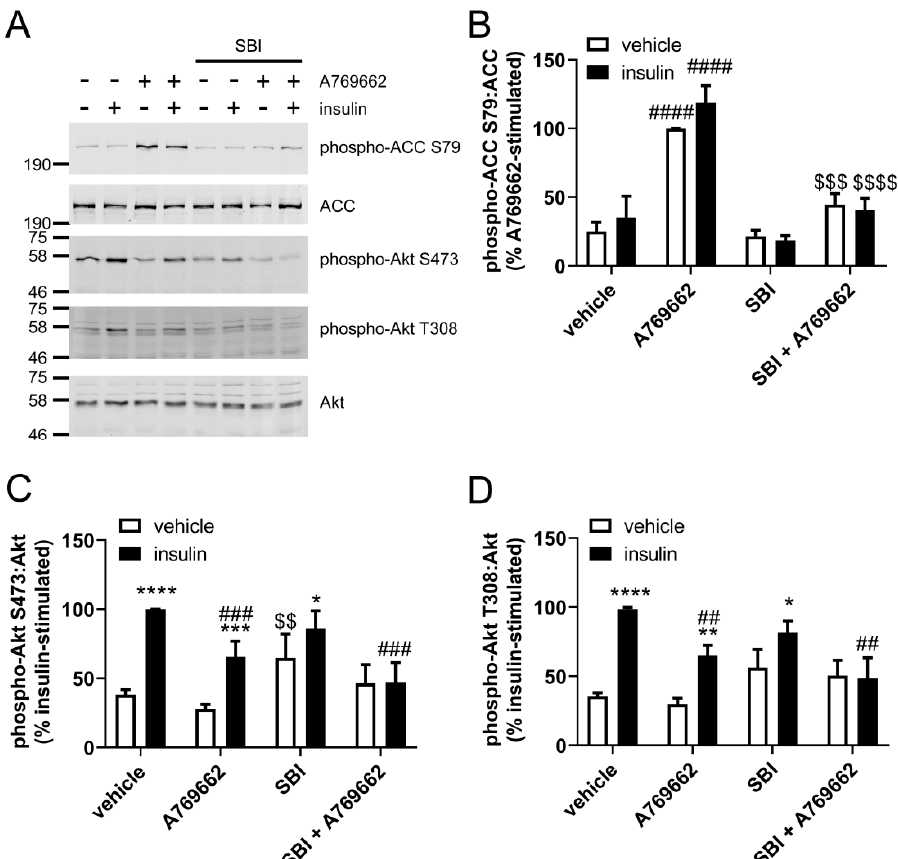
Figure 4. SBI-0206965 inhibits A769662-stimulated AMPK activation without altering inhibition of insulin-stimulated Akt phosphorylation in HUVECs. HUVECs were stimulated with A769662 (50 µM, 45 min) prior to insulin (1 µM, 15 min) after preincubation in the presence or absence of SBI-0206965 (SBI, 30 µM, 30 min) and cell lysates prepared. Proteins were resolved by SDS-PAGE and immunoblotted with the antibodies indicated. ( A ) Representative immunoblots from six biological replicates with molecular weight markers indicated. Densitometric quantification of ( B ) ACC, ( C ) Akt Ser473